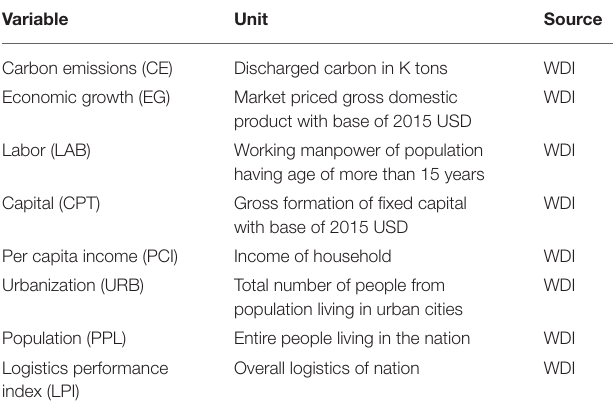
TABLE 1 | Source of all variables.